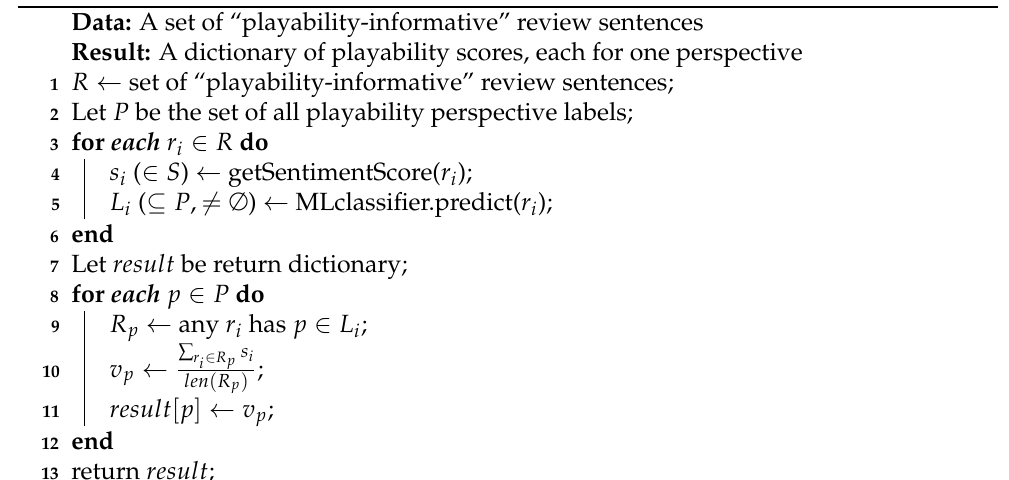
Algorithm 1: Algorithm of Quantifying the Playability on Multiple Perspectives. Data: A set of “playability-informative” review